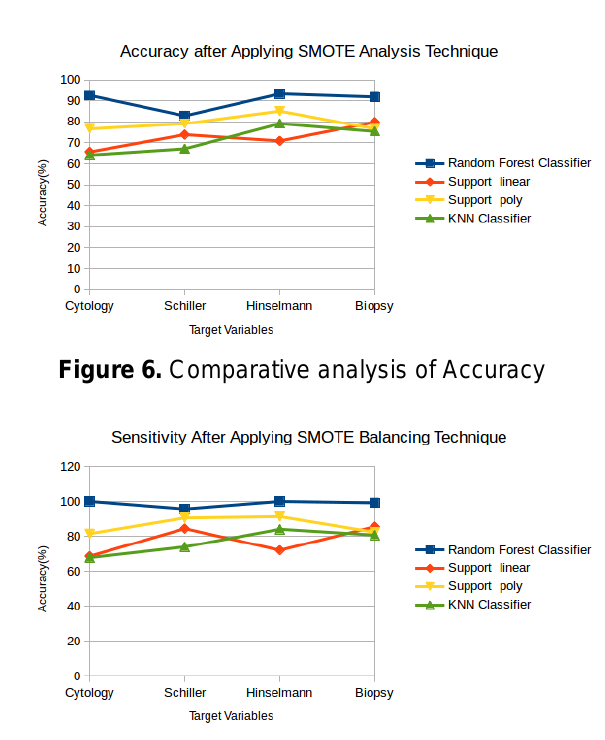
Figure 7. Comparative analysis for